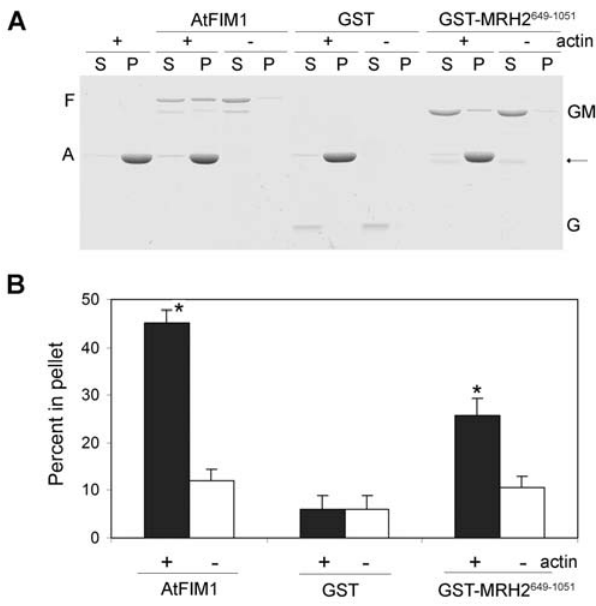
Figure 8. Binding of the ARM domain-containing MRH2 649-1051 polypeptide to the polymerized actin invitro. (A) A high-speed co- sedimentation assay for the binding of GST-MRH2 649-1051 Fragment to the polymerized actin. Equal amounts of GST-MRH2 649-1051 proteins were loaded in the presence ( + ) or the absence ( 2 ) of the polymerized actin. After high-speed centrifugation, proteins from the supernatant (S) and the pellet (P) were separated on the SDS-PAGE gel. AtFIM1 was used as a positive control, while GST as a negative control. The position of actin (A) and AtFIM1 (F) are marked at the left, and the positions of GST (G) and GST-MRH2 649-1051 (GM) are indicated at the right. Note that GST-MRH2 649-1051 might have a slight degradation (bands indicated by the arrow on the right). (B) Quantitative analysis of the percentage of proteins in the pellet. The three resulting gels were scanned to determine the amount of proteins that was present in the supernatant and the pellet fractions. After the background subtraction, the percentage of proteins that co-sedimented with the polymerized actin was calculated by dividing the intensities in the pellet from the sum of that in the pellet and the supernatant. The bar represents the average and the SD of three repeated experiments. The asterisk (*) above the column indicates a significant difference (p , 0.05) compared to the control of no actin.